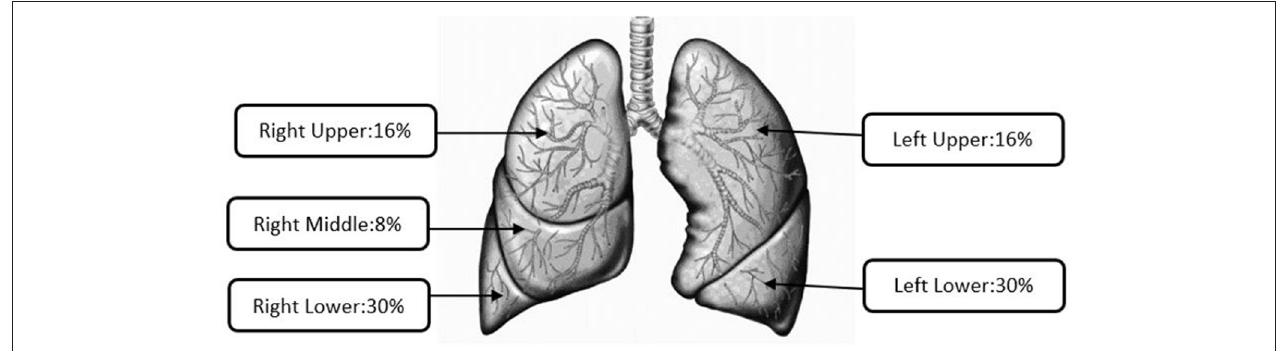
FIGURE 3 | Average lobular deposition for all